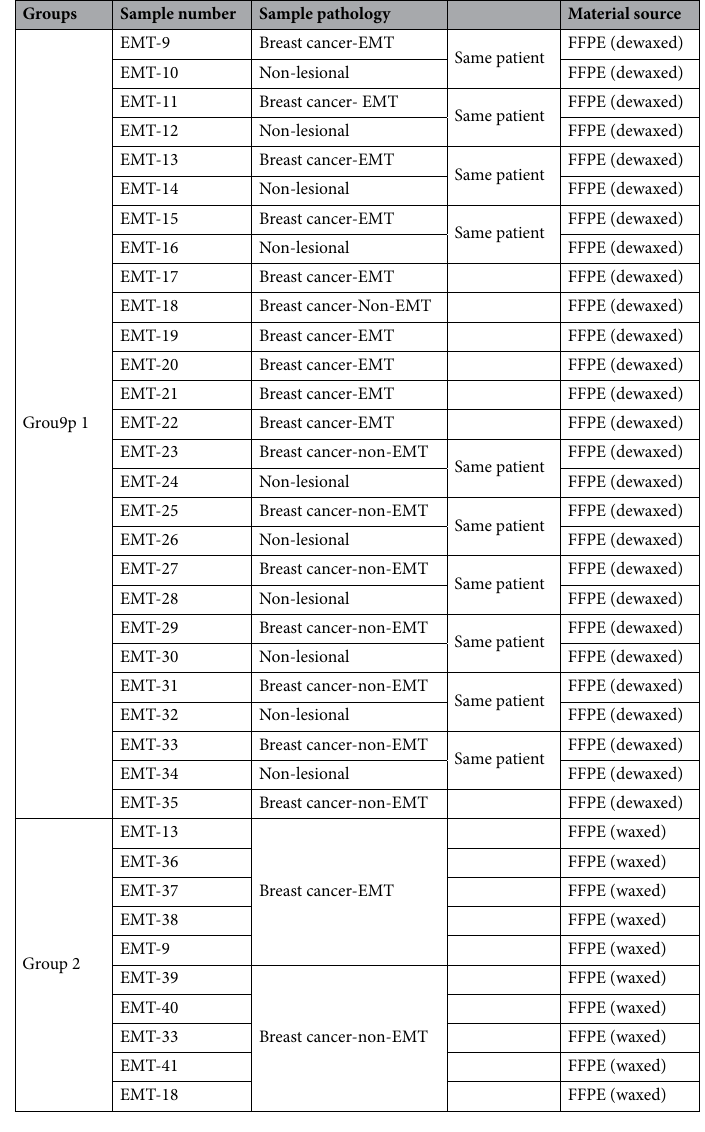
Table 1. The breast tissue samples classified on the basis of pathology and material